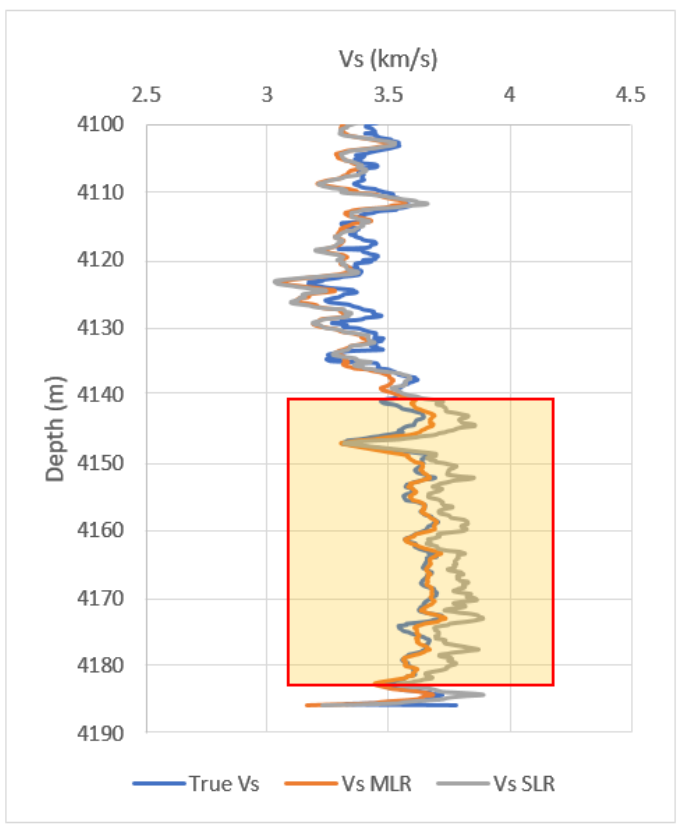
Figure 7. Improvement in the prediction of shear velocity in the hydrocarbon-bearing zone (highlighted zone): As seen MLR can predict Vs more accurate than SLR. Models were fitted in Well-3 and are validated in Well-2. Table 4. Neural network properties.